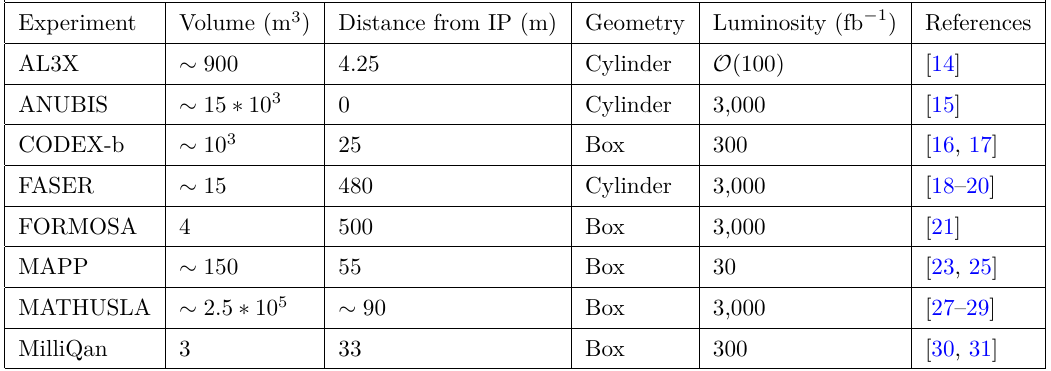
Table 1 . Overview of the long-lived particle detectors examined in this